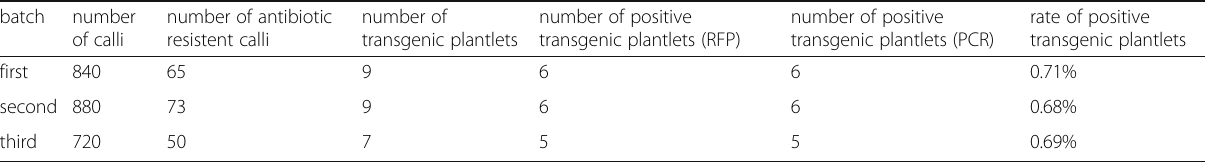
Table 1 Screen of transformed MingHui86 with the pFS4 vector batch